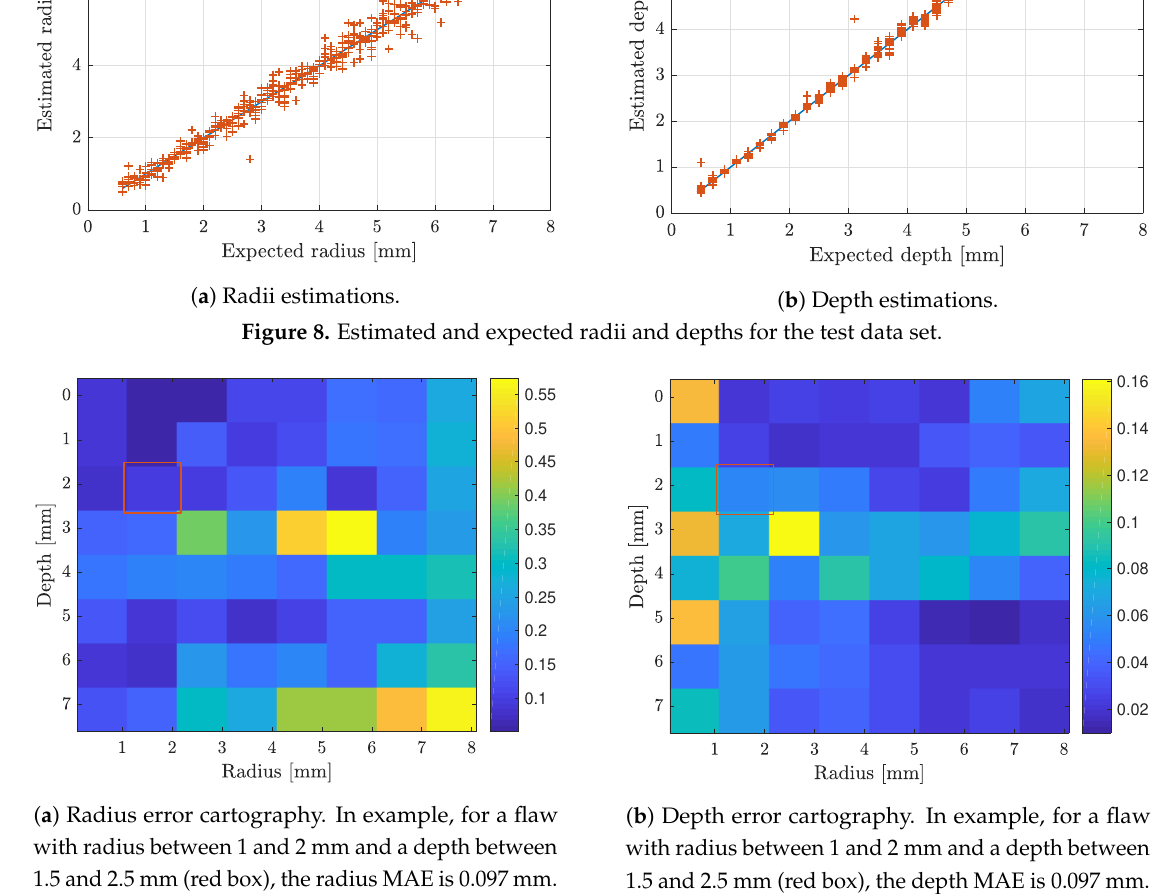
Figure 9. Cartography of the MAEs for estimated radii and depths in function of the real flaw